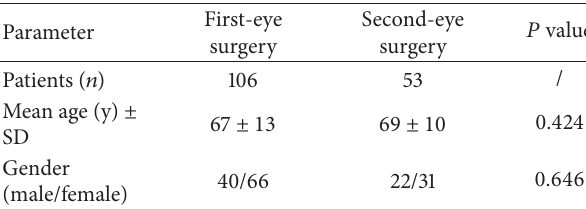
Table 1: Patient characteristics.